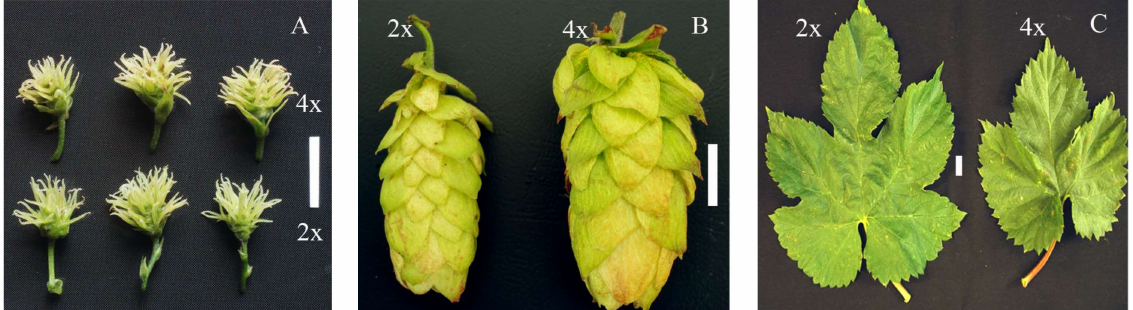
Figure 1. Flowers, hop cones and leaves of diploid and tetraploid H. lupulus “Sybilla”: ( A ) female flowers of diploid ( down ) and tetraploid ( up ) plants (bar = 10 mm), ( B ) hop cones of diploid ( left ) and tetraploid ( right ) plants (bar = 20 mm) and ( C ) fully expanded leaves of diploid ( left ) and tetraploid ( right ) plants (bar = 10 mm)